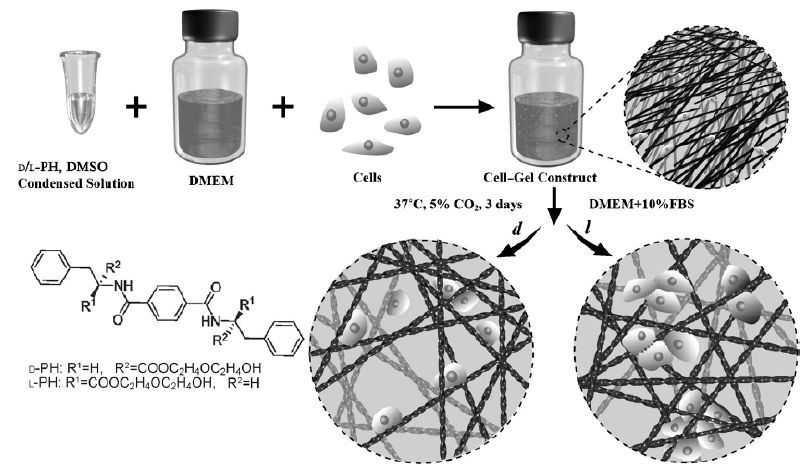
Figure 7. Schematic representation of the culture of fibroblast or endothelial cells in enantiomeric nanofibrous hydrogels ( d , l right-handed and left-handed helices, respectively). Reproduced with permission from [144], copyright 2014 Wiley.